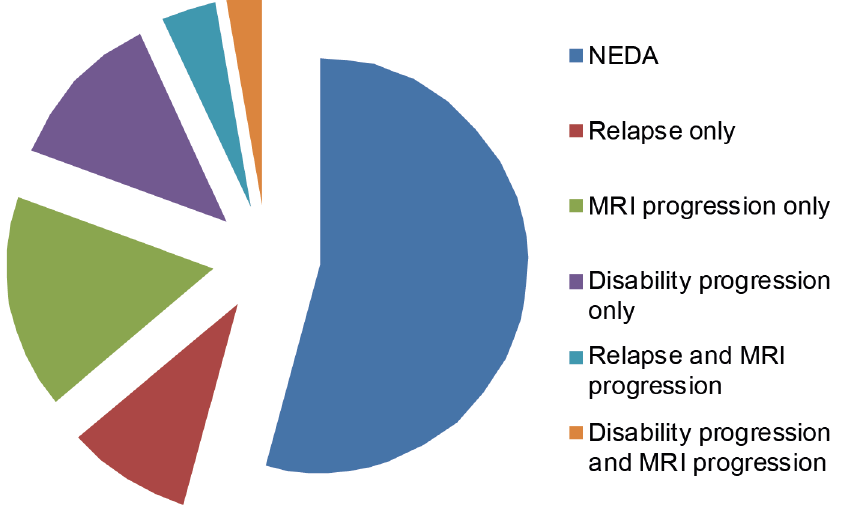
Fig 2. Evidence of disease activity at one-year follow-up. 54% of the patients were classified as NEDA after one year, while 46% of the patients showed either one or more evidences of disease